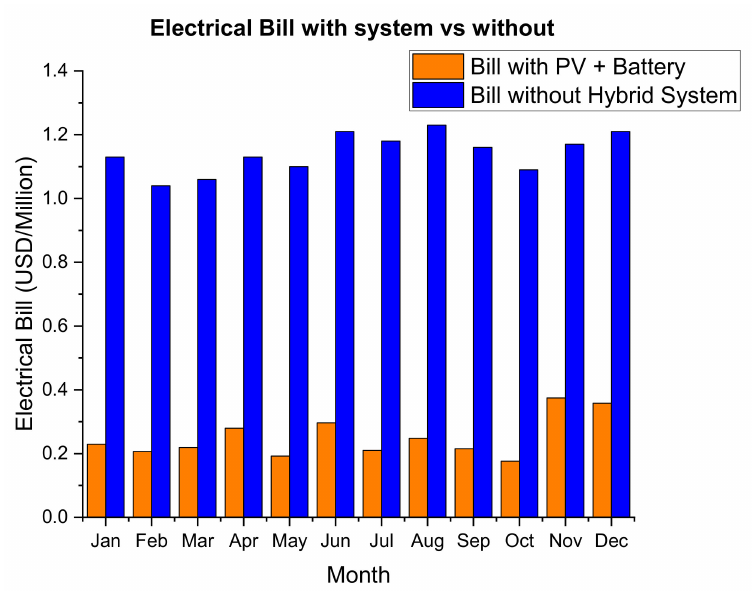
Figure 18. Monthly electric bill with the PV and battery system vs. without.